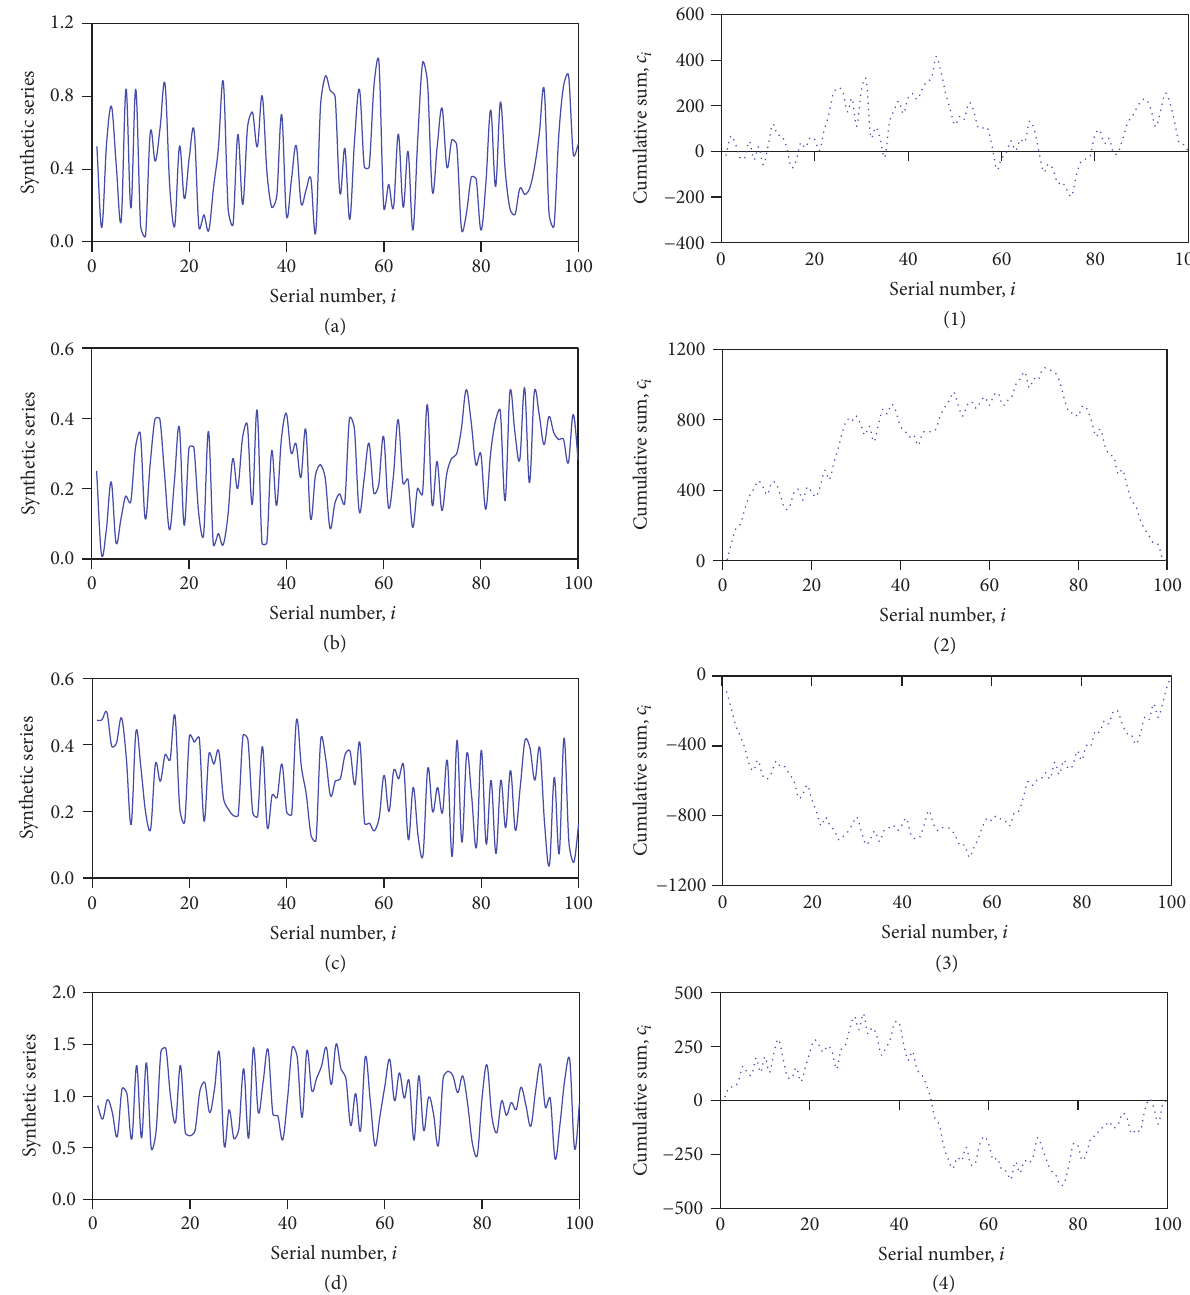
Figure 7: The CRD plots for (a)–(d) synthetic series and (1)–(4) the cumulative effects of the temporal variations for the corresponding